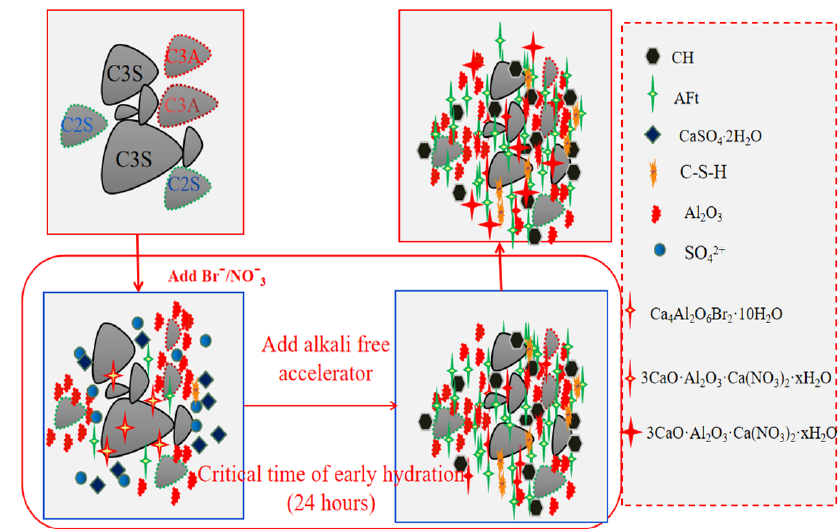
Figure 8. Schematic diagram of synergy.